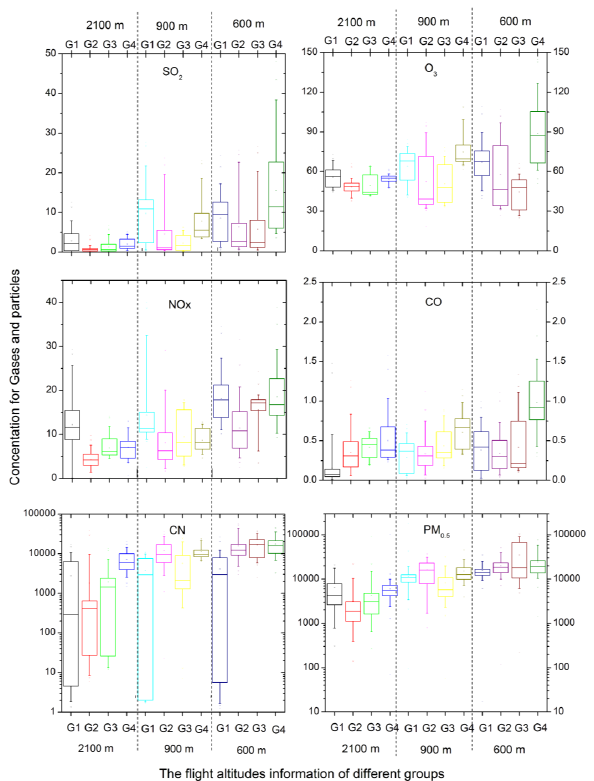
Fig. 2. The box-and-whisker plots for gaseous pollutants, condens- Fig. 2 The box and whisker plots for gases pollutants, condensable nuclei and PM 0.5 at able nuclei and PM 0 . 5 at different altitudes for each different altitudes of each group (The unit of CN, PM 0.5 are N/cm 3 , CO is ppmV, and other gases are ppbV)